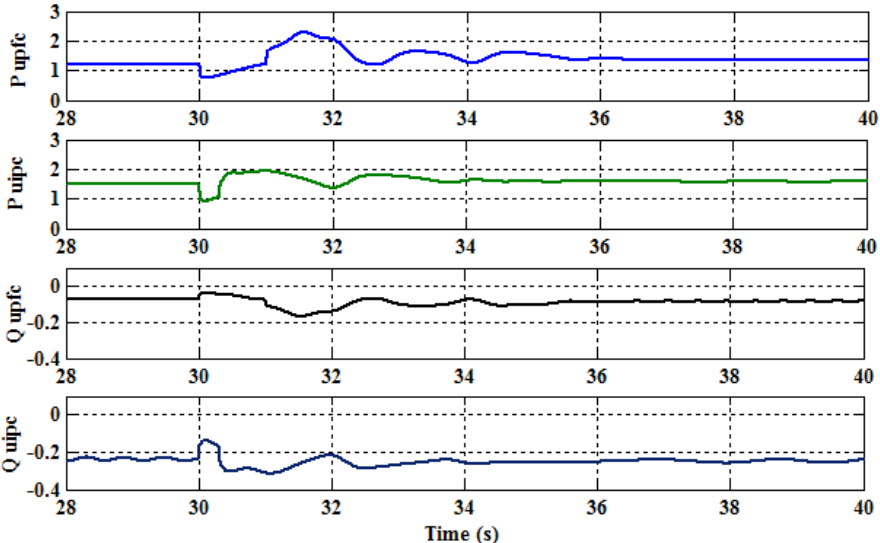
Figure 9. Active and reactive power outputs of the UIPC and UPFC.